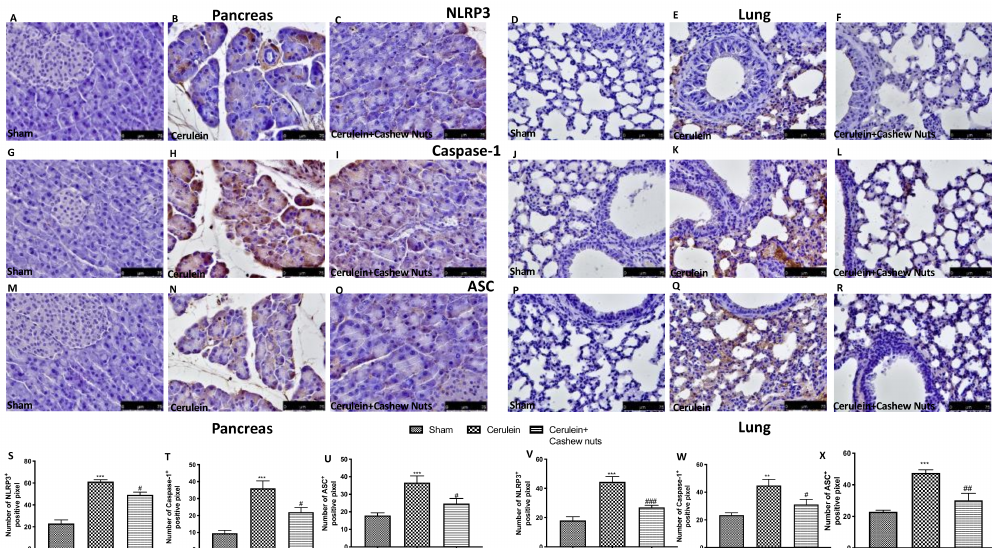
Figure 7. E ff ects of cashew nuts on the NLRP3 pathway in cerulein-induced AP as assessed by immunohistochemistry. Immunohistochemical staining for NLRP-3, Caspase-1, and ASC in pancreatic and lung tissue. NLRP3 immunohistochemical staining in pancreas (( A ) sham, ( B ) cerulein, ( C ) cerulein + cashew nuts) and lung (( D ) sham, ( E ) cerulein, ( F ) cerulein + cashew nuts), and relative densitometric quantification in pancreas ( S ) and lung ( V ). Caspase-1 immunohistochemical staining in pancreas (( G ) sham, ( H ) cerulein, ( I ) cerulein + cashew nuts) and (lung ( J ) sham, ( K ) cerulein, ( L ) cerulein + cashew nuts), and relative densitometric quantification in pancreas ( T ) and lung ( W ). ASC immunohistochemical staining in pancreas (( M ) sham, ( N ) cerulein, ( O ) cerulein + cashew nuts) and lung (( P ) sham, ( Q ) cerulein, ( R ) cashew nuts), and relative densitometric quantification in pancreas ( U ) and lung ( X ). # p < 0.05 vs. cerulein; ## p < 0.01 vs. cerulein; ### p < 0.001 vs. cerulein; *** p < 0.001 vs.